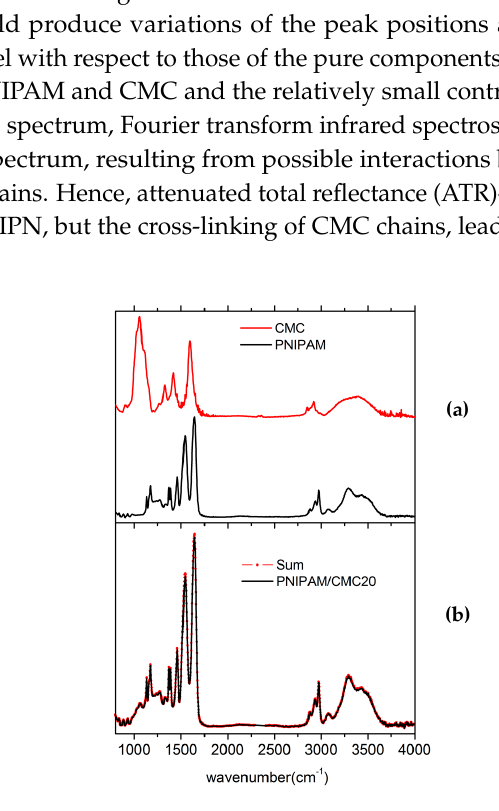
Figure 1. ( a ) Attenuated total reflectance–Fourier transform infrared spectroscopy (ATR-FTIR) spectra of carboxymethylcellulose (CMC) sodium salt and poly( N -isopropylacrylamide) (PNIPAM) hydrogel. The spectra were measured under the same instrumental conditions. ( b ) Fitting of the spectrum of the PNIPAM/CMC20 sample as a sum of the spectra of CMC and PNIPAM hydrogels weighted by optimized scaling factors. The spectra were measured for the lyophilized hydrogels.